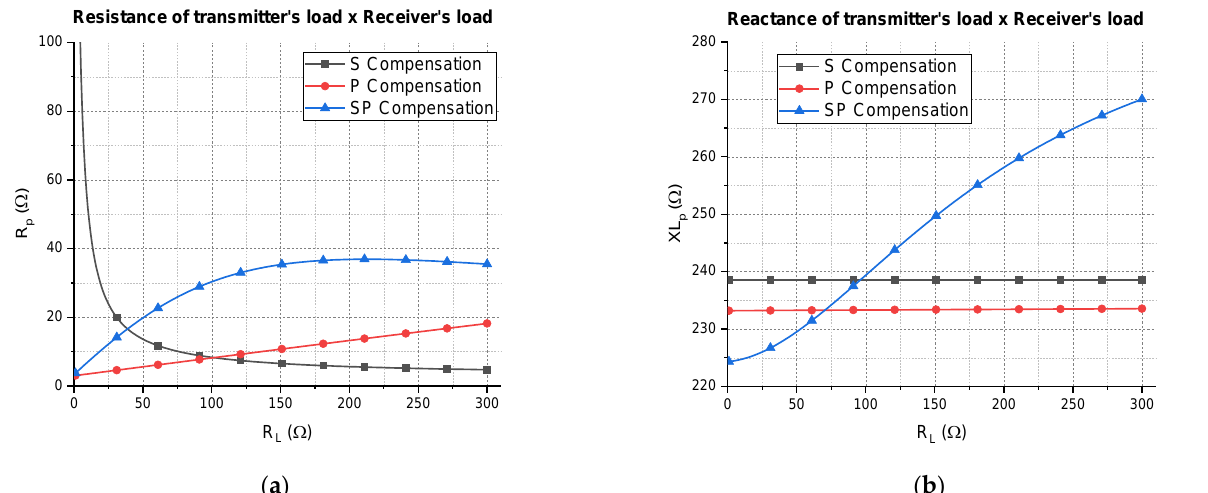
Figure 12. Theoretical transmitter’s load impedance caused by receivers of type S, P, and SP is represented as ( a ) real part vs. receiver’s load; ( b ) imaginary part vs. receiver’s load.